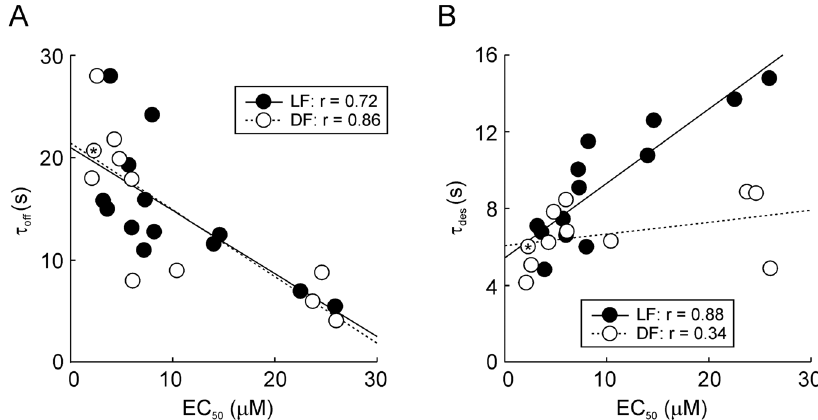
Figure 5. Deactivation and desensitization properties depend on the potency of ATP. (A, B) Correlation between EC 50 and the deactivation time constant t off (A) and EC 50 and desensitization time constant t des (B) for alanine DF and LF mutants. DF mutants are shown as open circles and LF mutants as closed circles. WT receptors are shown as an asterisk in an open circle. Values are derived from Table S1. Correlation analysis was performed as described in the Methods.